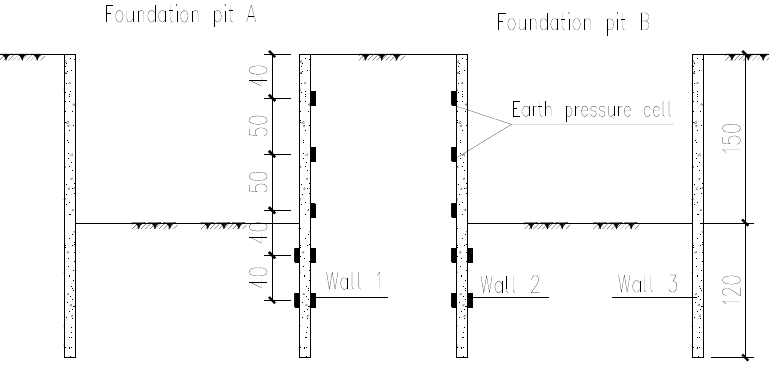
Figure 4. Layout diagram of earth pressure cells.